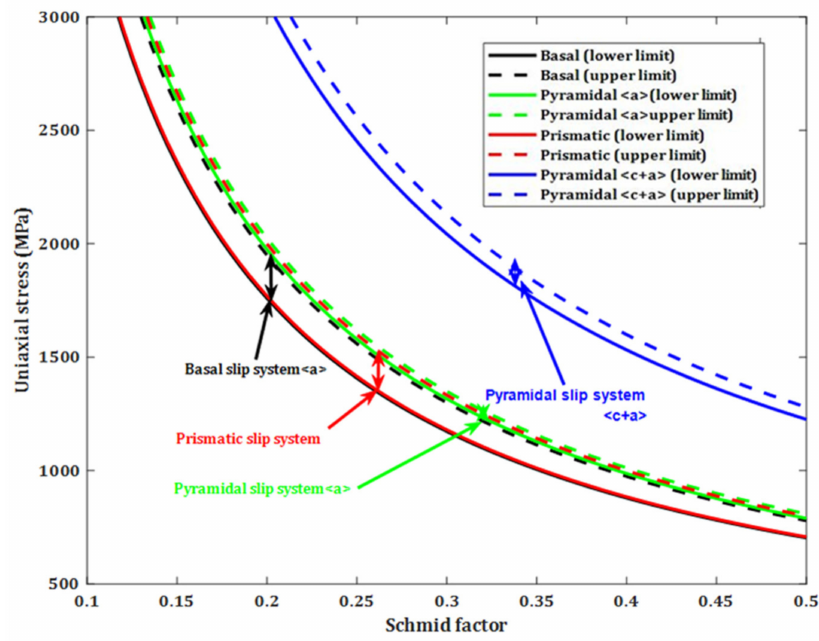
Figure 11. Uniaxial stresses required to initiate slip in four different slip systems of α -hcp (Ti6Al4V- polycystals) at different levels of global Schmid